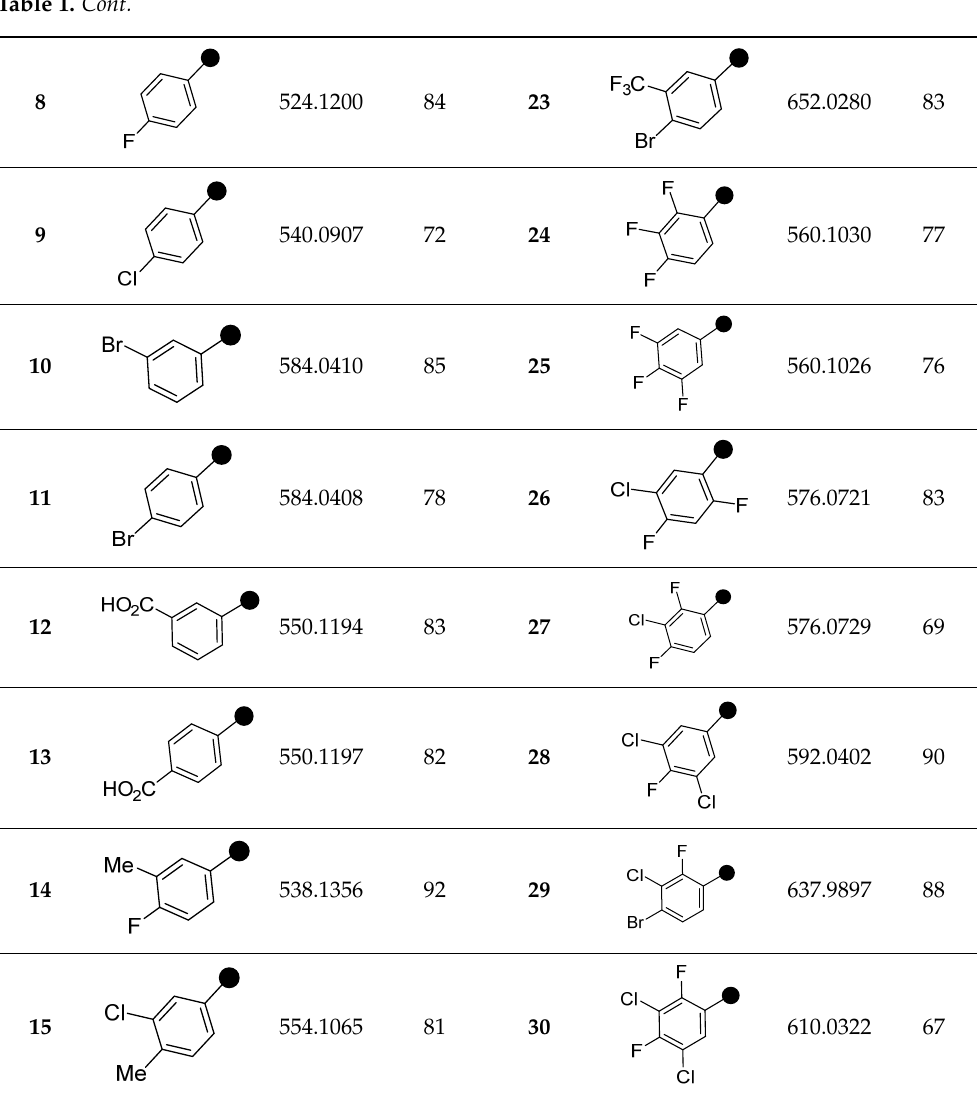
compounds ( 7 and 8 ) were good bacterial growth inhibitors. 3-Fluoro derivative ( 7 ) was found to be slightly less potent than the 4-fluoro derivative ( 8 ). Chloro-substitution re- sulted in a compound ( 9 ) with better activity than the fluoro derivatives. Bromo deriva- tives ( 10 and 11 ) are both potent antimicrobial agents, and the 4-chloro ( 9 ) showed similar antimicrobial activity. The carboxylic acid functional group eliminated the activity of the resultant compounds ( 12 and 13 ). resultant compounds ( 12 and 13 ). Table 2. MIC (µg/mL) data of the synthesized compounds. Gram-positive: Antibiotic susceptible S. aureus ATCC 25923 Table 2. MIC (µg/mL) data of the synthesized compounds. Gram-positive: Antibiotic susceptible S. aureus ATCC 25923 Table 2. MIC (µg/mL) data of the synthesized compounds. Gram-positive: Antibiotic susceptible S. aureus ATCC 25923 Table 2. MIC (µg/mL) data of the synthesized compounds. Gram-positive: Antibiotic susceptible S. aureus ATCC 25923 Table 2. MIC (µg/mL) data of the synthesized compounds. Gram-positive: Antibiotic susceptible S. aureus ATCC 25923 Table 2. MIC (µg/mL) data of the synthesized compounds. Gram-positive: Antibiotic susceptible S. aureus ATCC 25923 Table 2. MIC (µg/mL) data of the synthesized compounds. Gram-positive: Antibiotic susceptible S. aureus ATCC 25923 Table 2. MIC (µg/mL) data of the synthesized compounds. Gram-positive: Antibiotic susceptible S. aureus ATCC 25923 (Sa23), antibiotic-resistant (methicillin-resistant) strains: S. aureus BAA-2312 (Sa12), S. aureus ATCC 33591 (Sa91), S. aureus (Sa23), antibiotic-resistant (methicillin-resistant) strains: S. aureus BAA-2312 (Sa12), S. aureus ATCC 33591 (Sa91), S. aureus Table 2. MIC (µg/mL) data of the synthesized compounds. Gram-positive: Antibiotic susceptible S. aureus ATCC 25923 Table 2. MIC (µg/mL) data of the synthesized compounds. Gram-positive: Antibiotic susceptible S. aureus ATCC 25923 (Sa23), antibiotic-resistant (methicillin-resistant) strains: S. aureus BAA-2312 (Sa12), S. aureus ATCC 33591 (Sa91), S. aureus (Sa23), antibiotic-resistant (methicillin-resistant) strains: S. aureus BAA-2312 (Sa12), S. aureus ATCC 33591 (Sa91), S. aureus (Sa23), antibiotic-resistant (methicillin-resistant) strains: S. aureus BAA-2312 (Sa12), S. aureus ATCC 33591 (Sa91), S. aureus (Sa23), antibiotic-resistant (methicillin-resistant) strains: S. aureus BAA-2312 (Sa12), S. aureus ATCC 33591 (Sa91), S. aureus (Sa23), antibiotic-resistant (methicillin-resistant) strains: S. aureus BAA-2312 (Sa12), S. aureus ATCC 33591 (Sa91), S. aureus (Sa23), antibiotic-resistant (methicillin-resistant) strains: S. aureus BAA-2312 (Sa12), S. aureus ATCC 33591 (Sa91), S. aureus ATCC 33592 (Sa92), and S. aureus ATCC 700699 (Sa99); S. epidermidis ATCC 700296 (Se), antibiotic susceptible E. faecalis ATCC 33592 (Sa92), and S. aureus ATCC 700699 (Sa99); S. epidermidis ATCC 700296 (Se), antibiotic susceptible E. faecalis (Sa23), antibiotic-resistant (methicillin-resistant) strains: S. aureus BAA-2312 (Sa12), S. aureus ATCC 33591 (Sa91), S. aureus (Sa23), antibiotic-resistant (methicillin-resistant) strains: S. aureus BAA-2312 (Sa12), S. aureus ATCC 33591 (Sa91), S. aureus ATCC 33592 (Sa92), and S. aureus ATCC 700699 (Sa99); S. epidermidis ATCC 700296 (Se), antibiotic susceptible E. faecalis ATCC 33592 (Sa92), and S. aureus ATCC 700699 (Sa99); S. epidermidis ATCC 700296 (Se), antibiotic susceptible E. faecalis ATCC 33592 (Sa92), and S. aureus ATCC 700699 (Sa99); S. epidermidis ATCC 700296 (Se), antibiotic susceptible E. faecalis ATCC 29212 (Ef12), antibiotic-resistant (vancomycin-resistant, VRE) E. faecalis ATCC 51299 (Ef99), antibiotic-resistant (vancomycin-resistant, VRE) E. faecium ATCC 700221 (Ef21), Bacillus subtilis ATCC 6623 (Bs), V = Vancomycin and D = Daptomycin, n = 3. # ATCC 33592 (Sa92), and S. aureus ATCC 700699 (Sa99); S. epidermidis ATCC 700296 (Se), antibiotic susceptible E. faecalis ATCC 29212 (Ef12), antibiotic-resistant (vancomycin-resistant, VRE) E. faecalis ATCC 51299 (Ef99), antibiotic-resistant (vancomycin-resistant, VRE) E. faecium ATCC 700221 (Ef21), Bacillus subtilis ATCC 6623 (Bs), V = Vancomycin and D = Daptomycin, n = 3. # ATCC 29212 (Ef12), antibiotic-resistant (vancomycin-resistant, VRE) E. faecalis ATCC 51299 (Ef99), antibiotic-resistant (vancomycin-resistant, VRE) E. faecium ATCC 700221 (Ef21), Bacillus subtilis ATCC 6623 (Bs), V = Vancomycin and D = Daptomycin, n = 3. # ATCC 29212 (Ef12), antibiotic-resistant (vancomycin-resistant, VRE) E. faecalis ATCC 51299 (Ef99), antibiotic-resistant (vancomycin-resistant, VRE) E. faecium ATCC 700221 (Ef21), Bacillus subtilis ATCC 6623 (Bs), V = Vancomycin and D = Daptomycin, n = 3. # ATCC 29212 (Ef12), antibiotic-resistant (vancomycin-resistant, VRE) E. faecalis ATCC 51299 (Ef99), antibiotic-resistant (vancomycin-resistant, VRE) E. faecium ATCC 700221 (Ef21), Bacillus subtilis ATCC 6623 (Bs), V = Vancomycin and D = Daptomycin, n = 3. # ATCC 29212 (Ef12), antibiotic-resistant (vancomycin-resistant, VRE) E. faecalis ATCC 51299 (Ef99), antibiotic-resistant (vancomycin-resistant, VRE) E. faecium ATCC 700221 (Ef21), Bacillus subtilis ATCC 6623 (Bs), V = Vancomycin and D = Daptomycin, n = 3. # ATCC 33592 (Sa92), and S. aureus ATCC 700699 (Sa99); S. epidermidis ATCC 700296 (Se), antibiotic susceptible E. faecalis ATCC 29212 (Ef12), antibiotic-resistant (vancomycin-resistant, VRE) E. faecalis ATCC 51299 (Ef99), antibiotic-resistant (vancomycin-resistant, VRE) E. faecium ATCC 700221 (Ef21), Bacillus subtilis ATCC 6623 (Bs), V = Vancomycin and D = Daptomycin, n = 3. # ATCC 33592 (Sa92), and S. aureus ATCC 700699 (Sa99); S. epidermidis ATCC 700296 (Se), antibiotic susceptible E. faecalis ATCC 29212 (Ef12), antibiotic-resistant (vancomycin-resistant, VRE) E. faecalis ATCC 51299 (Ef99), antibiotic-resistant (vancomycin-resistant, VRE) E. faecium ATCC 700221 (Ef21), Bacillus subtilis ATCC 6623 (Bs), V = Vancomycin and D = Daptomycin, n = 3. # ATCC 33592 (Sa92), and S. aureus ATCC 700699 (Sa99); S. epidermidis ATCC 700296 (Se), antibiotic susceptible E. faecalis ATCC 29212 (Ef12), antibiotic-resistant (vancomycin-resistant, VRE) E. faecalis ATCC 51299 (Ef99), antibiotic-resistant (vancomycin-resistant, VRE) E. faecium ATCC 700221 (Ef21), Bacillus subtilis ATCC 6623 (Bs), V = Vancomycin and D = Daptomycin, n = 3. # ATCC 33592 (Sa92), and S. aureus ATCC 700699 (Sa99); S. epidermidis ATCC 700296 (Se), antibiotic susceptible E. faecalis ATCC 29212 (Ef12), antibiotic-resistant (vancomycin-resistant, VRE) E. faecalis ATCC 51299 (Ef99), antibiotic-resistant (vancomycin-resistant, VRE) E. faecium ATCC 700221 (Ef21), Bacillus subtilis ATCC 6623 (Bs), V = Vancomycin and D = Daptomycin, n = 3.